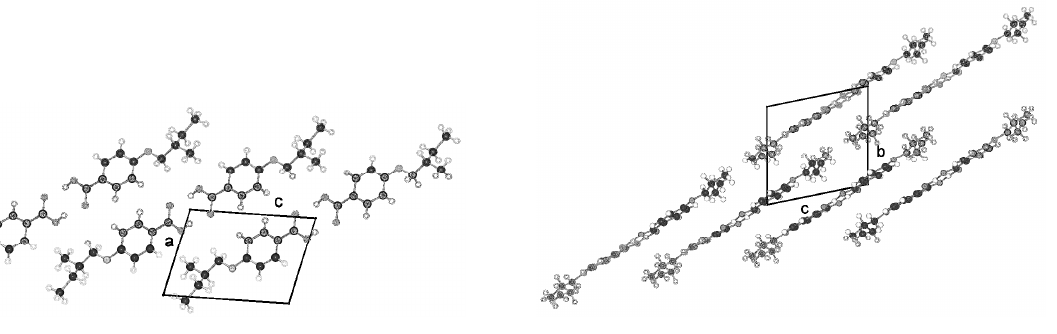
Figure 10. Representation of the packing arrangement of S -MBOBA, space group P1, in two projections along [010] and [100] to show the sheet-like structure. A